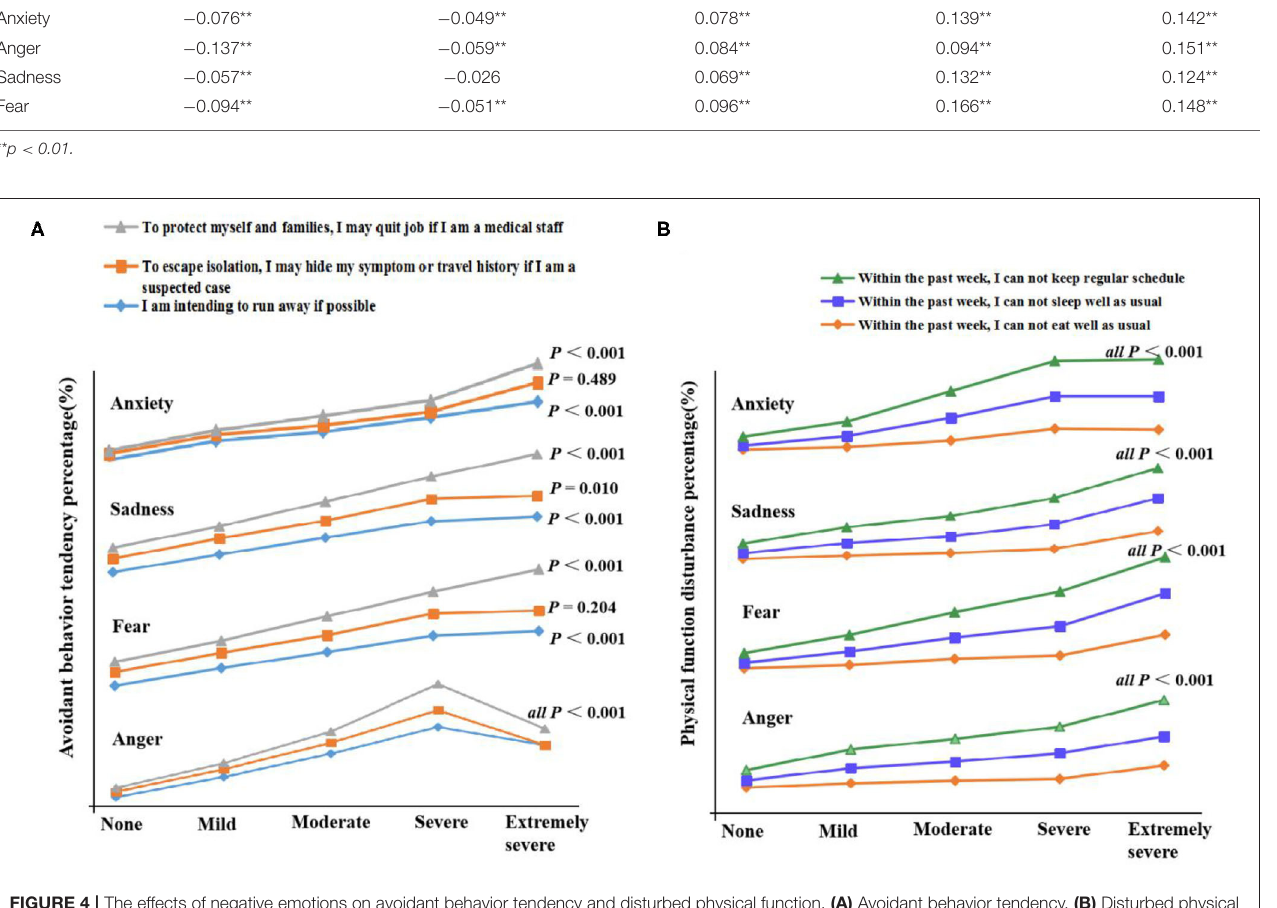
function (0.005–0.02). The results indicated a positive effect between negative emotion and risk perception, avoidant behavior tendency, and disturbed physical function, in which negative emotion and avoidant behavior tendency played a mediation